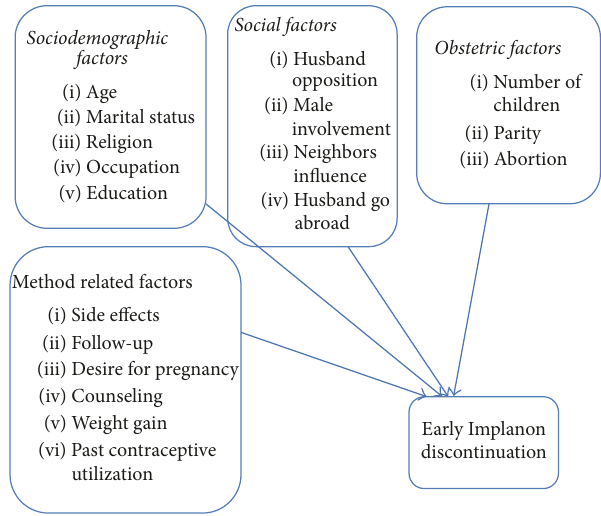
Figure 1: Conceptual framework adapted from review of literatures on early Implanon discontinuation and associated factors [11,